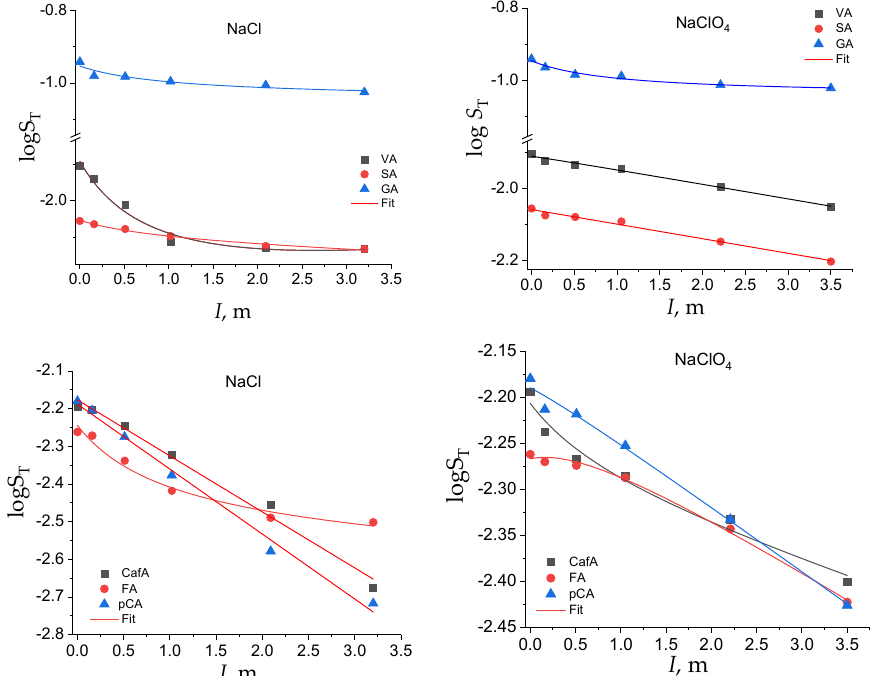
Figure 2. Total solubility in the logarithmic scale of the hydroxybenzoic and hydroxycinnamic acids as a function of the solvent salts and of the ionic strength.